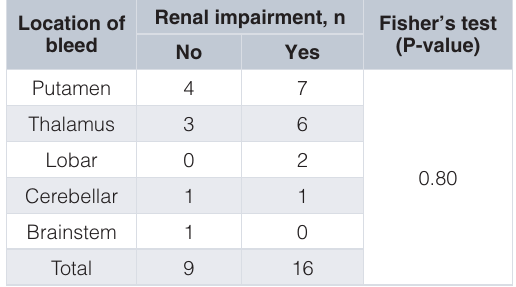
Table 3. Cross tabulation of haemorrhagic stroke patients with and without renal impairment according to the location of